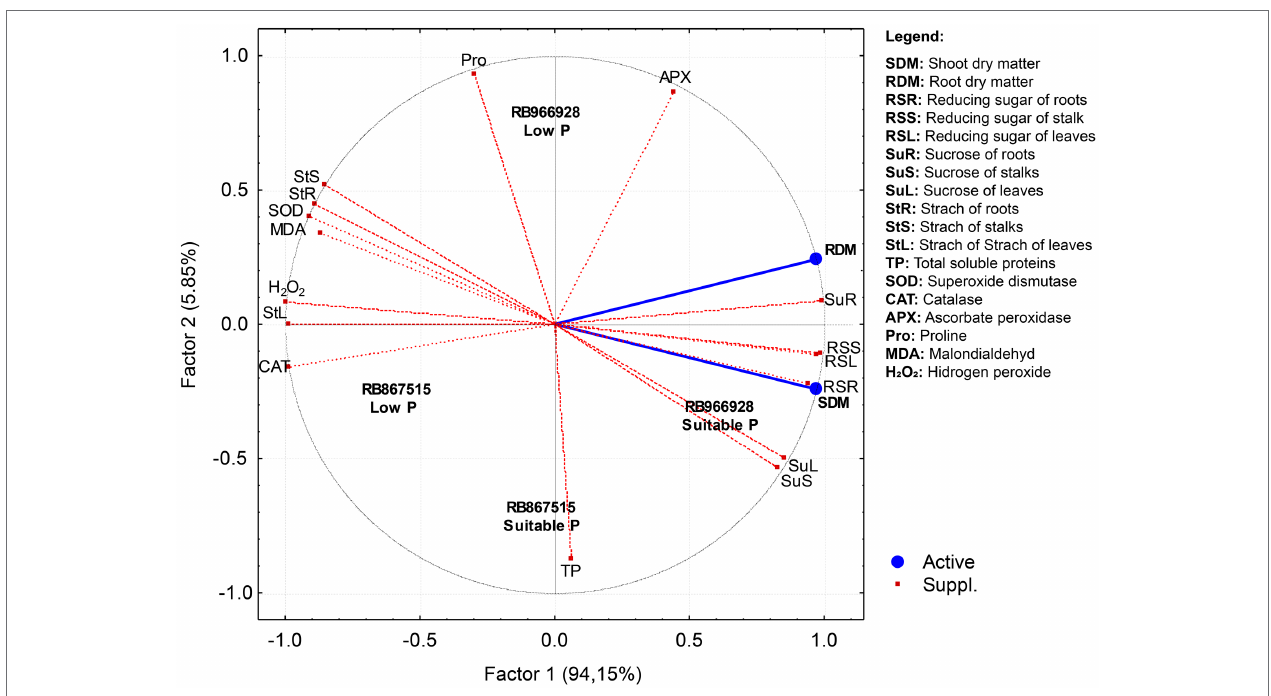
FIGURE 5 | Projection of dataset based on correlations between P levels and sugarcane varieties subjected to principal component analysis